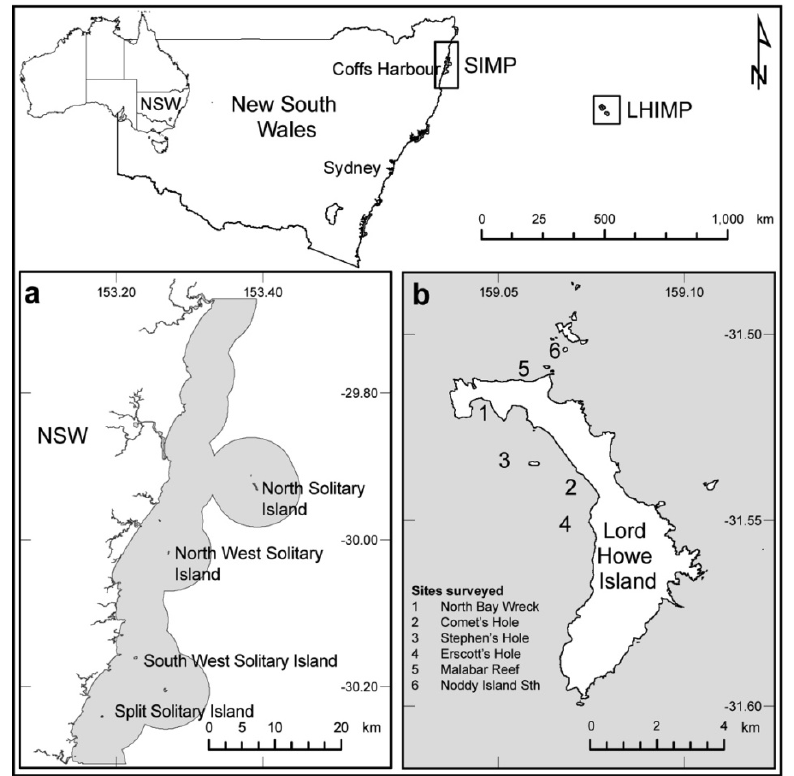
Figure 1. Location of the Solitary Islands Marine Park (SIMP) and Lord Howe Island Marine Park (LHIMP) northern New South Wales, Australia: ( a ) SIMP (grey shaded area)—two sites were located on the north-western side of four islands: North Solitary Island (NSI), North West Solitary Island (NWSI), South West Solitary Island (SWSI) and Split Solitary Island (SSI); ( b ) LHIMP (grey shaded area)—four lagoon and two exposed sites were surveyed during May